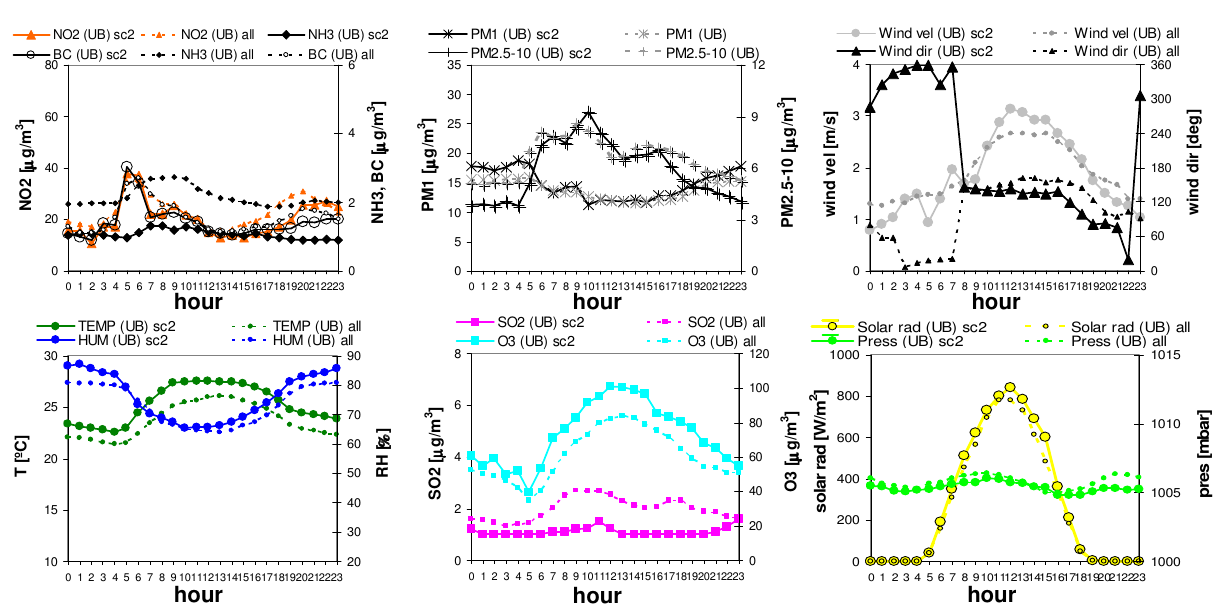
Fig. 11. Mean diurnal cycles of aerosol components and parameters measured at UB station during the period 1–5 August (Special Case